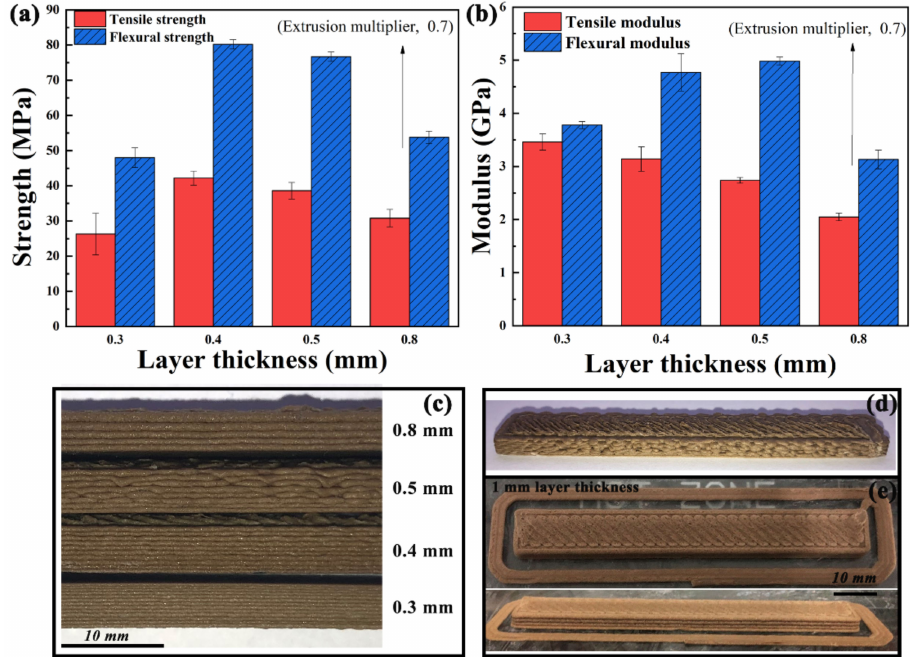
Figure 9. ( a ) Mechanical strength and ( b ) modulus, and ( c ) morphology in layer thickness direction of samples printed with various layer thicknesses. ( d ) Over-extrusion in 0.8 mm layer thickness. ( e ) 1 mm layer thickness test